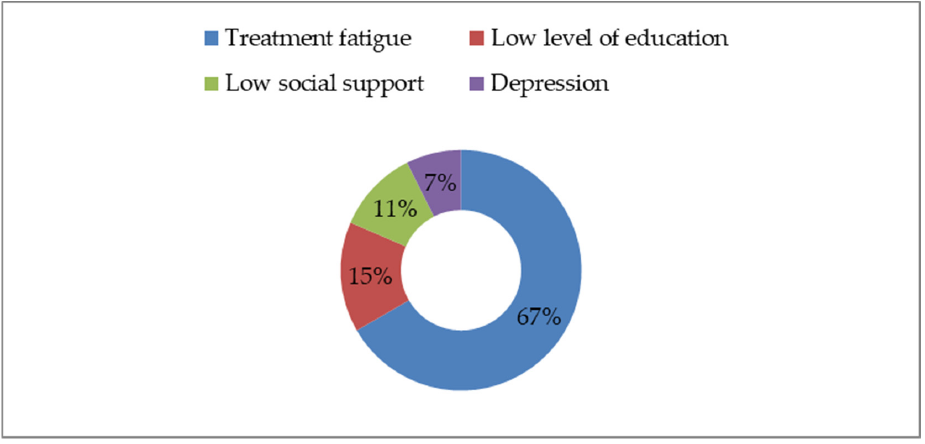
Figure 2. Factors influencing adherence with ART.